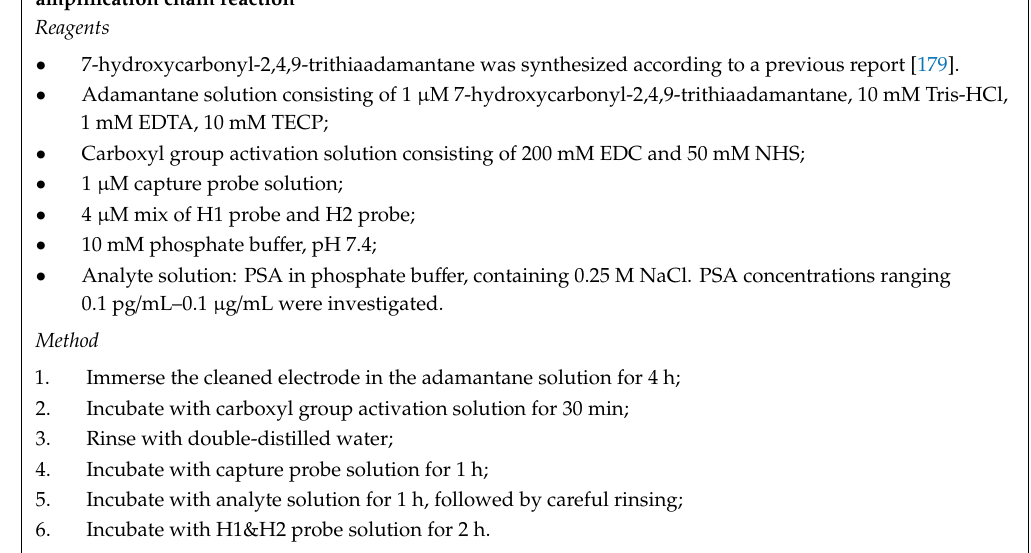
Protocol A8 by Ding et al. [105]: Adamantane as surface anchor for aptamers and signal amplification